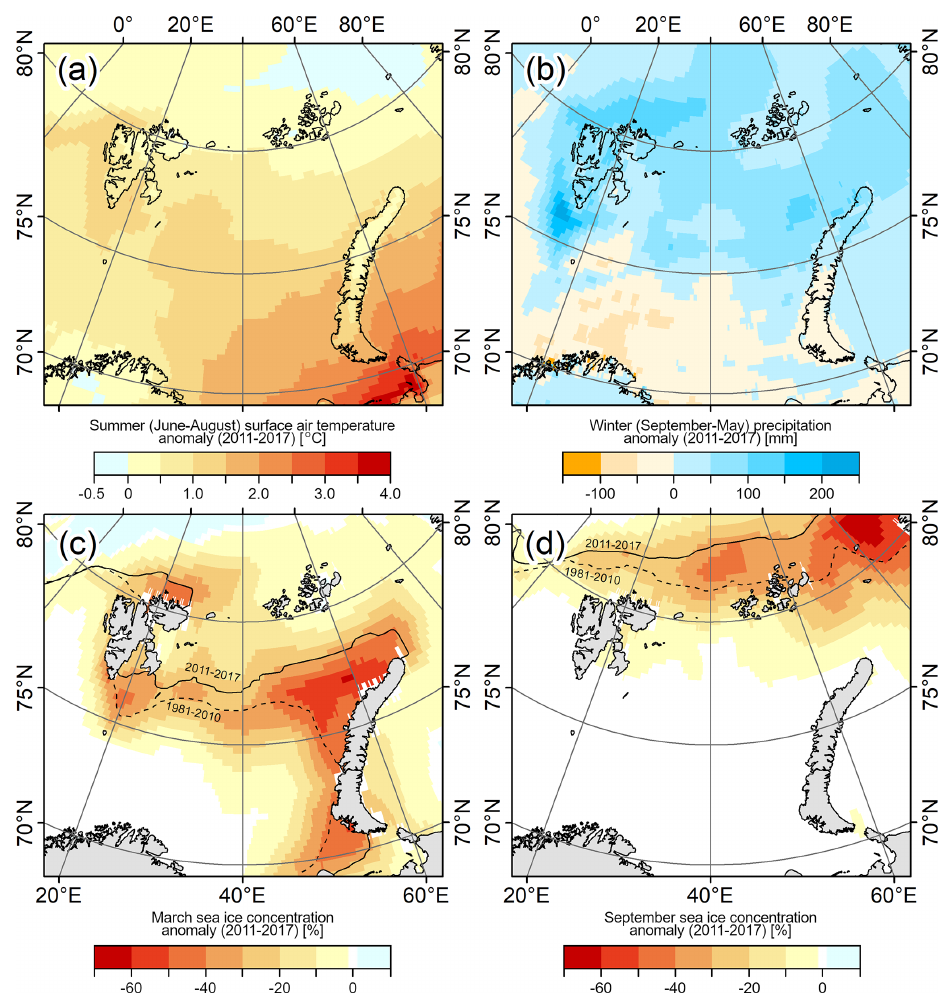
Figure 2. The 2011–2017 anomalies of selected climate variables from the ERA5 reanalysis in reference to the period 1981–2010. (a) Sum- mer (June–August) near-surface air temperature anomaly. (b) Winter (September–May) precipitation anomaly. (c) March sea ice concentra- tion anomaly. (d) September sea ice concentration anomaly. Dashed and solid black lines in (c) and (d) signify 50% sea ice concentration extent for 1981–2010 and 2011–2017,